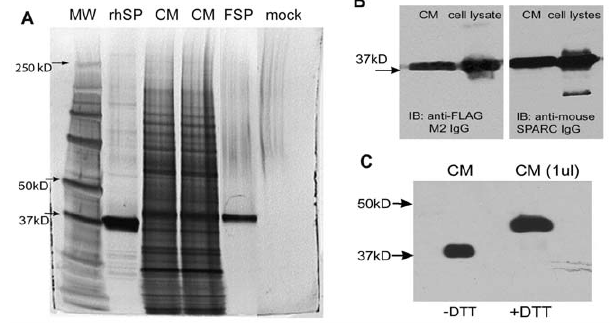
Figure 1. Production and purification of FSP. Conditioned medium (CM) from baculovirus infected Sf21 insect cells was subjected to immuno-affinity chromatography on anti-FLAG M1 affinity gel. CM (15 ul of culture supernate), rhSP (rhSPARC, purified by anion-exchange chromatography), FSP (5 ul of eluted fraction), and mock (buffer control) were separated by SDS-PAGE on a 10% gel under non-reducing conditions, and were visualized by silver stain ( A ); note the other bands in the purified rhSPARC sample, but not in the FSP sample ( B ), 1 ul of CM of infected Sf21 cell lysates ( , 5 ug total protein per lane) was resolved by SDS-PAGE under non-reducing conditions, transferred to a PVDF membrane, and probed with anti-FLAG M2 IgG or polyclonal anti- mouse SPARC IgG. ( C ), 1 ul CM was diluted in sample buffer and was boiled for 5 min in the presence ( + ) or absence ( 2 ) of 50 mM DTT. Proteins were resolved by SDS-PAGE, followed by immunoblotting for SPARC. A shift of FSP from Mr , 38,000 to , 44,000 was apparent.